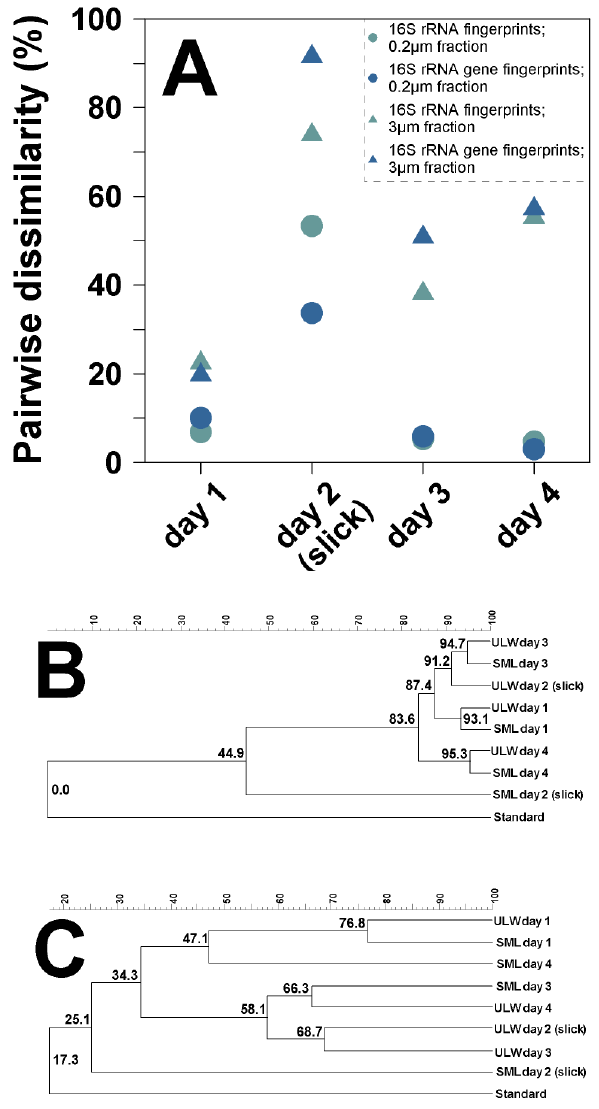
Fig. 2. Analysis of the bacterial community composition in the Baltic Sea field study based on 16S rRNA and 16S rRNA gene fingerprints. (A) Pairwise dissimilarity between bacterioneuston (SML) and bacterioplankton (ULW) community profiles for the particle-attached and non-attached fraction. (B, C) Cluster analy- ses of 16S rRNA fingerprints of the non-attached (B) and of the particle-attached (C) fractions show strong changes in the bacteri- oneuston community during slick